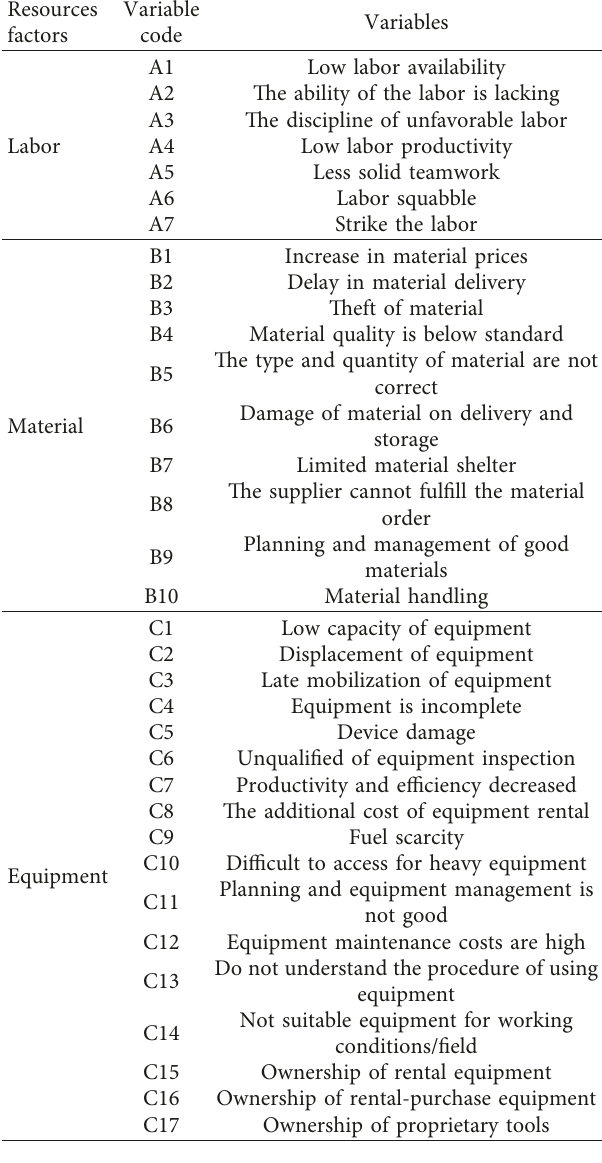
Table 1: List of factors and variables of project resources [20,